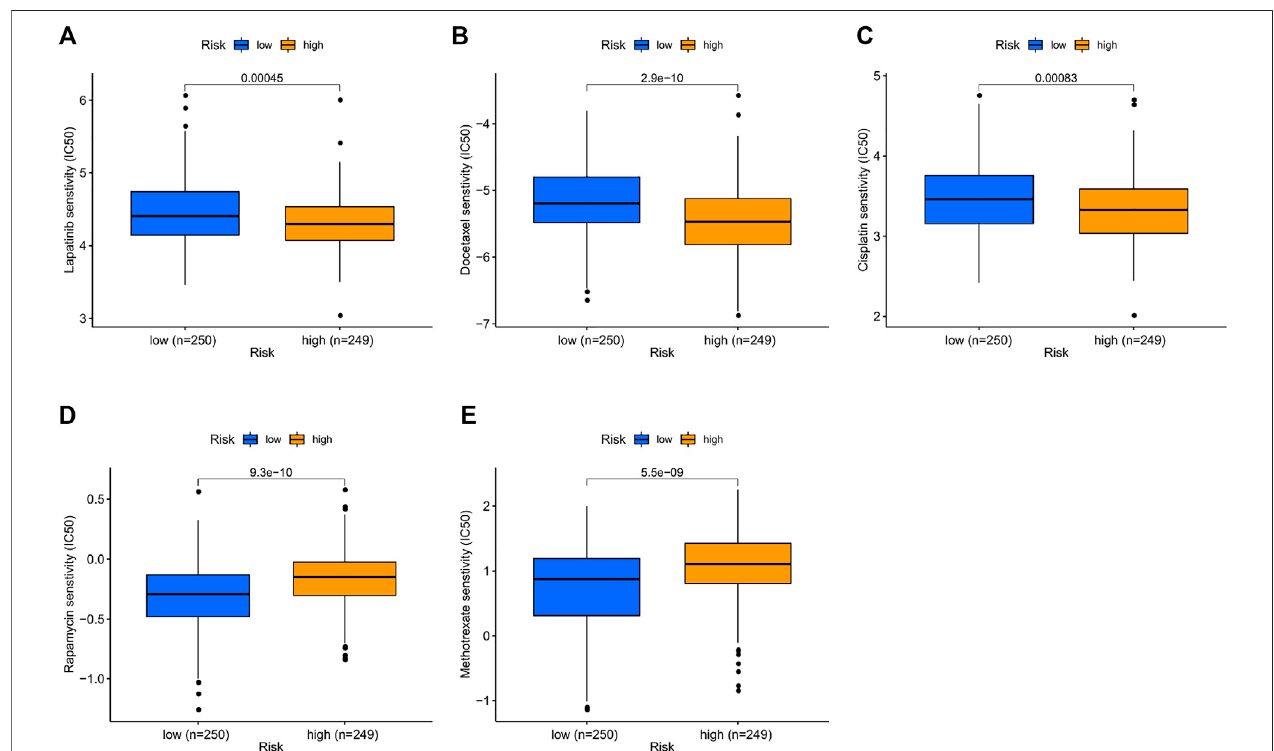
FIGURE 8 | Prediction sensitivity of chemotherapy bene fi t in high- ( n = 249) and low-risk groups ( n = 250). (A) Lapatinib. (B) Docetaxel. (C) Cisplatin. (D) Rapamycin. (E) Methotrexate.